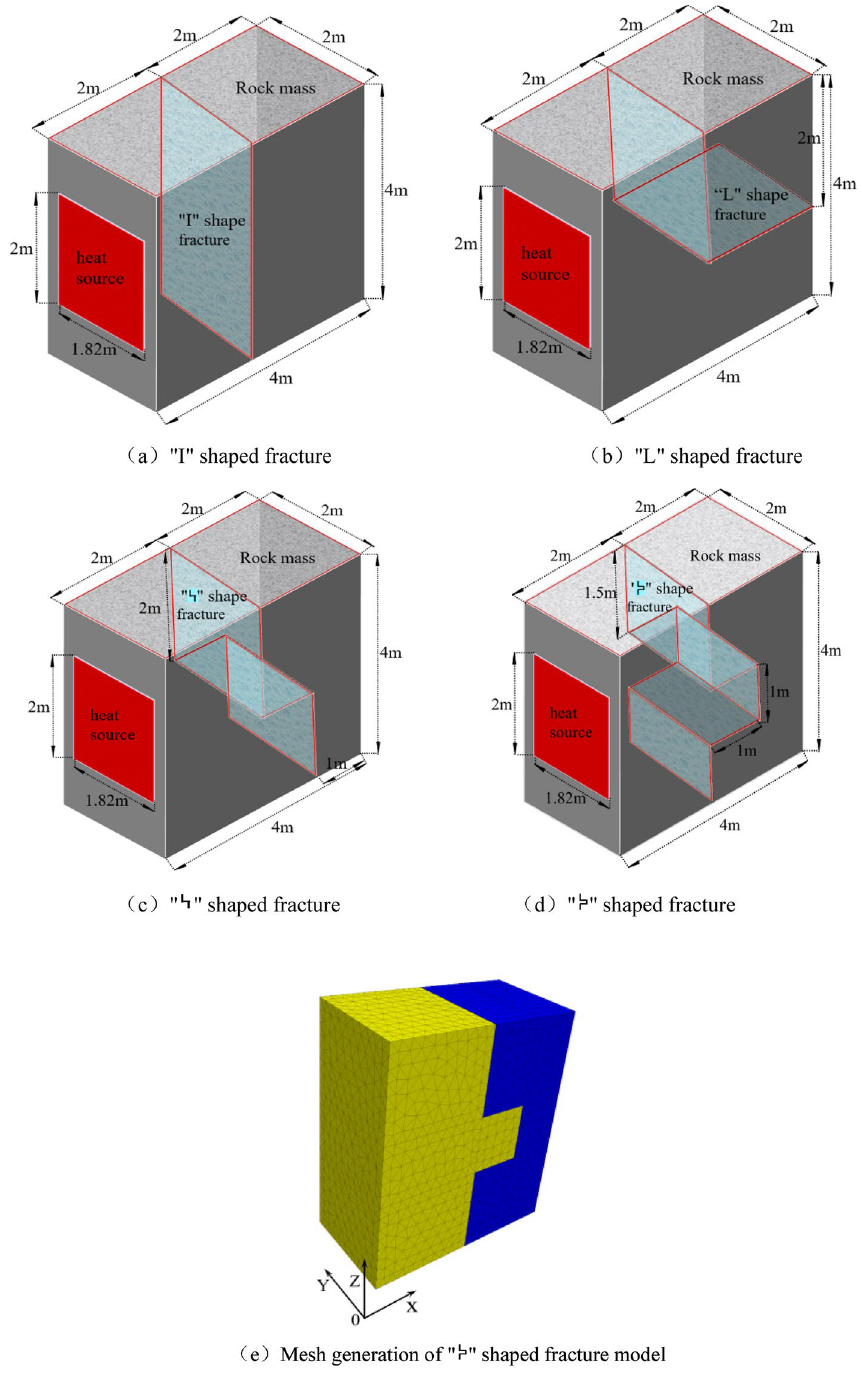
Figure 2. Calculate model dimension and mesh generation (Dimension unit: m).